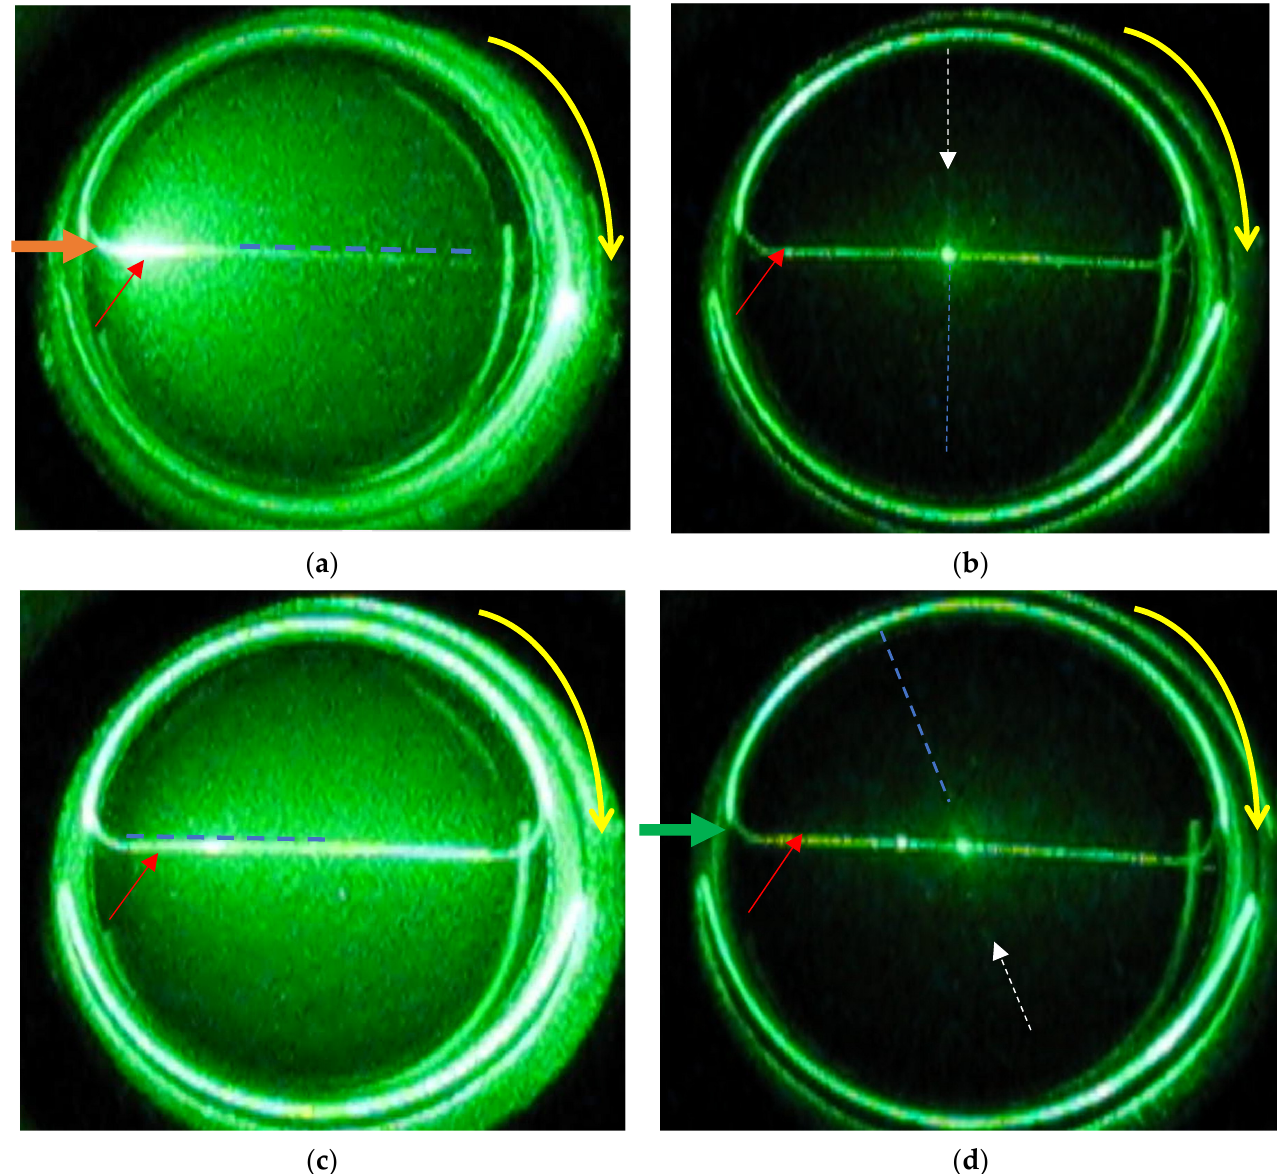
Figure 5. Sequence of images taken from a video recording of VIC-T polymerization and crosslinking of monomeric components under exposition to a laser light of 532 nm at 5 mW for 60 min. VIC-T sample after irradiation was left in a goniometer and it was rotated clockwise (indicated with yellow arrow): ( a ) is for the sample at 0 ◦ with respect to original position, ( b ) is for the sample at 90 ◦ with respect to original position, ( c ) is for the sample at 180 ◦ with respect to original position and ( d ) is for the sample at 250 ◦ with respect to original position. Arrows and line in the photographs denote, as follows: red arrow—laser beam passing through the sample; blue dash line—a prolongation of the white line corresponding to polymerized and crosslinked monomers; white dash arrow points to the white line as the blue line does; orange arrow in ( a )—incident green laser light beam. Note that the white line corresponding to the polymerized monomers of VIC-T is hardly visible; therefore, it was marked with the blue dash line.